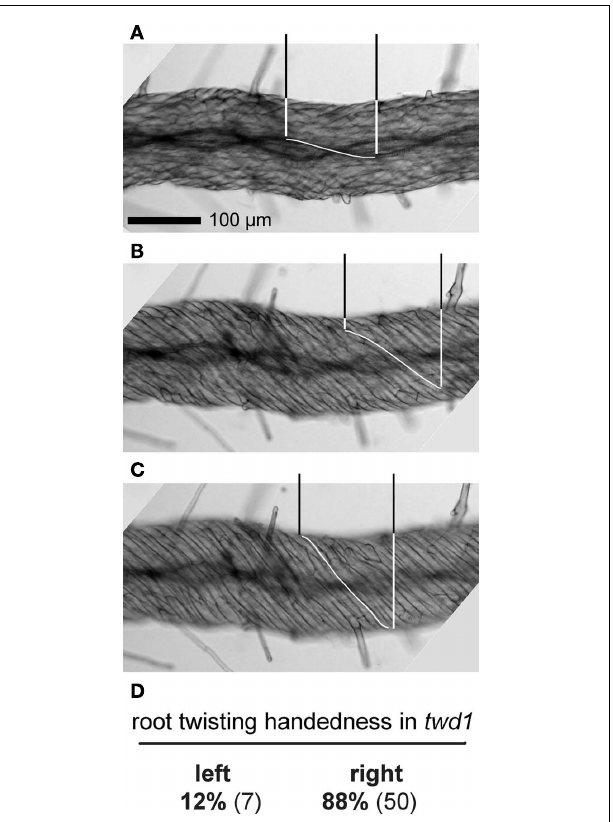
FIGURE 3 | Light micrographs of an Arabidopsis twd1 root, taken with the focal plane in the organ mid-plane (A), the parenchymal root cortex (B), and the epidermis (C). The pitch of the helically rotating cell files increases from the organ center toward the periphery. In each micrograph, the distance along the organ axis required by a cell file (xylem strands in (A) , cortical parenchyma in (B) , epidermal cells in (C) ) to complete a semicircular rotation of 180˚ is highlighted for one exemplary file.These distances are practically identical in (A–C) , indicating that all cell files twist in phase around the organ axis. (D) Handedness of root twisting in twd1 observed in the first 3mm of the root tip. Roots were stained with Toluidine blue; other experimental details as in Figure 2